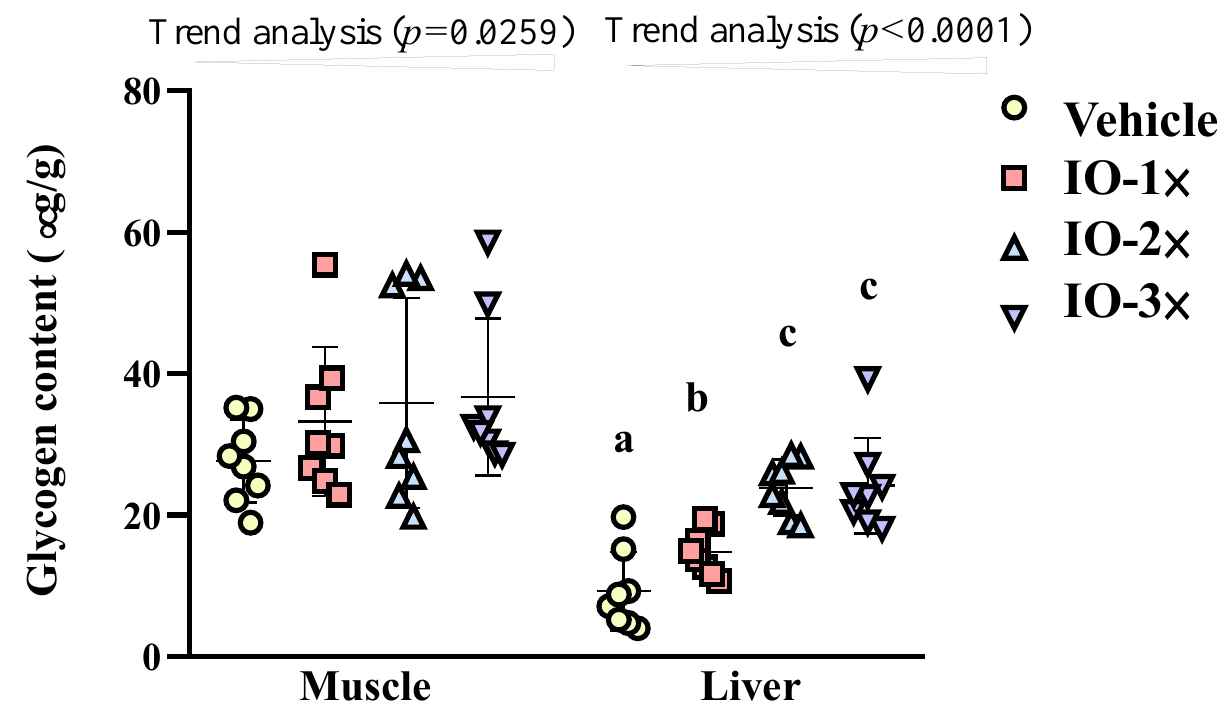
Figure 5. Effect of IO on muscle and liver glycogen levels at rest. All the mice were euthanized and tested for glycogen levels in muscle tissues 1 h after the final treatment. Data represent the mean ± SD of eight mice in each group. A one-way analysis of variance (ANOVA) was used for the analysis. Different letters (a, b, c) indicate a significant difference at p < 0.05.